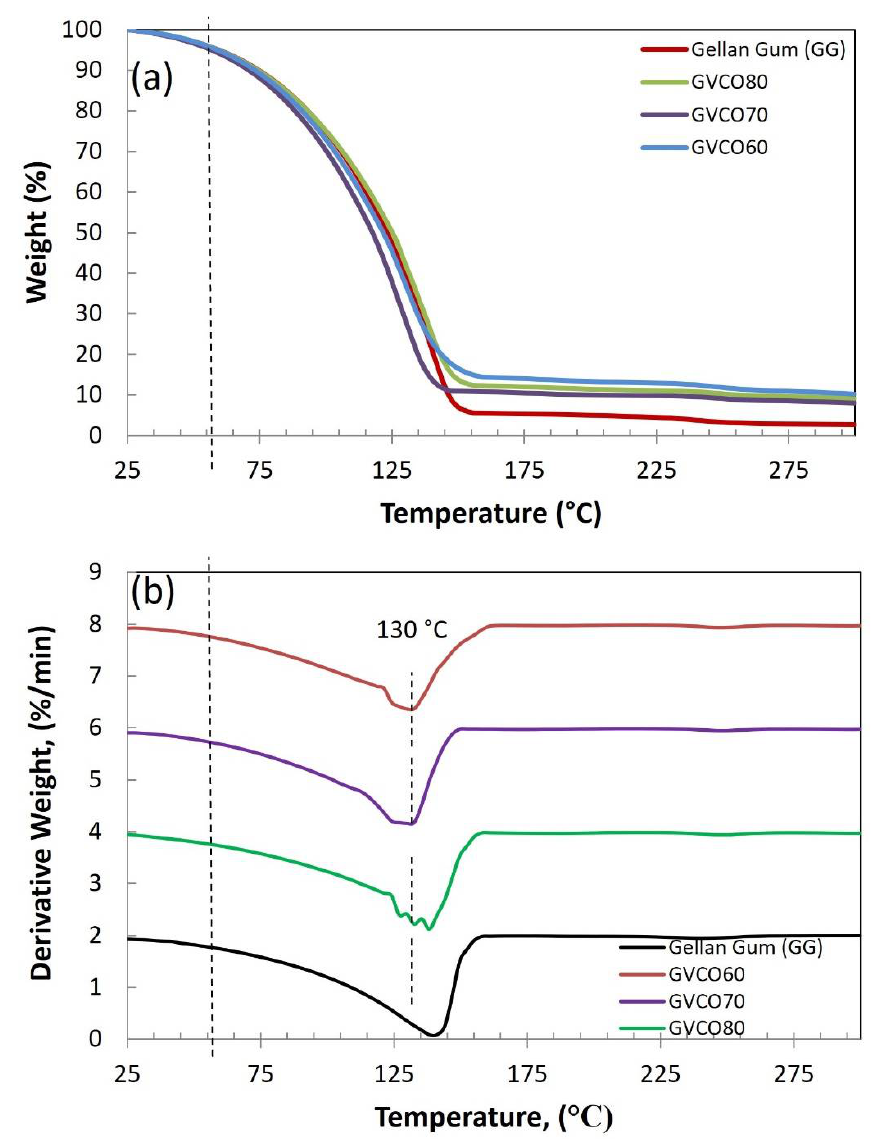
Figure 5. ( a ) Thermogravimetric thermograms and ( b ) derivative thermograms of GG and GVCO hydrogels at different concentrations. Table 3. Thermal gravimetric properties of gellan gum (GG) and GVCO hydrogels.